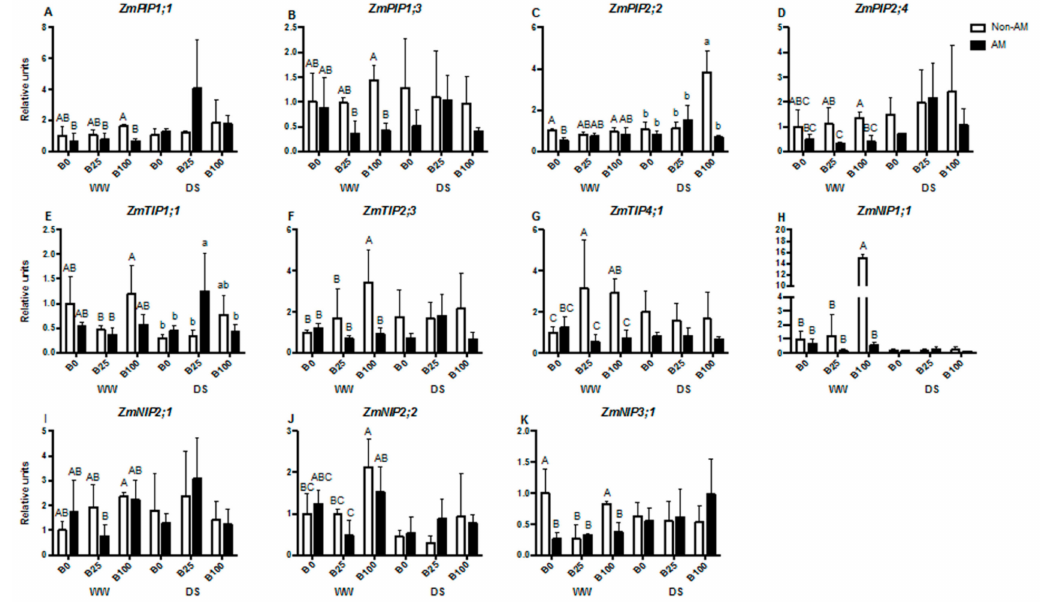
Figure 4. Relative mRNA levels of ZmPIP1;1 ( A ), ZmPIP1;3 ( B ), ZmPIP2;2 ( C ), ZmPIP2;4 ( D ), ZmTIP1;1 ( E ), ZmTIP2;3 ( F ), ZmTIP4;1 ( G ), ZmNIP1;1 ( H ), ZmNIP2;1 ( I ), ZmNIP2;2 ( J ) and ZmNIP3;1 ( K